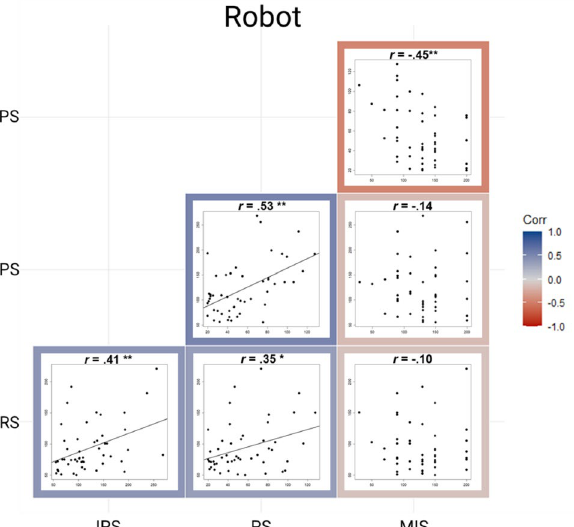
Figure 4. Correlation matrix plot showing the relation between RS, IPS, PS and MIS when facing the virtual robot. The r refers to the Spearman coefficient when the correlation includes MIS and to the Pearson coefficient when it does not. ** p -values < .001, * p -values <